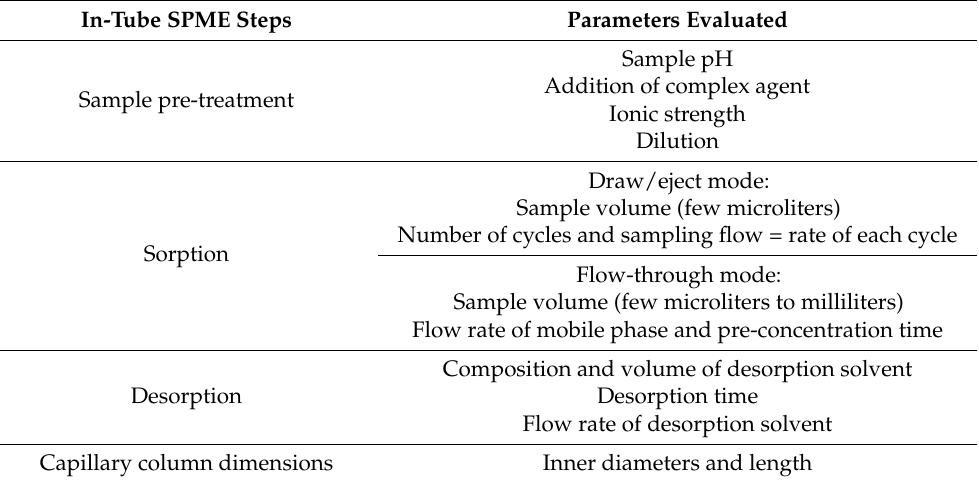
Table 1. Optimization of the in-tube SPME